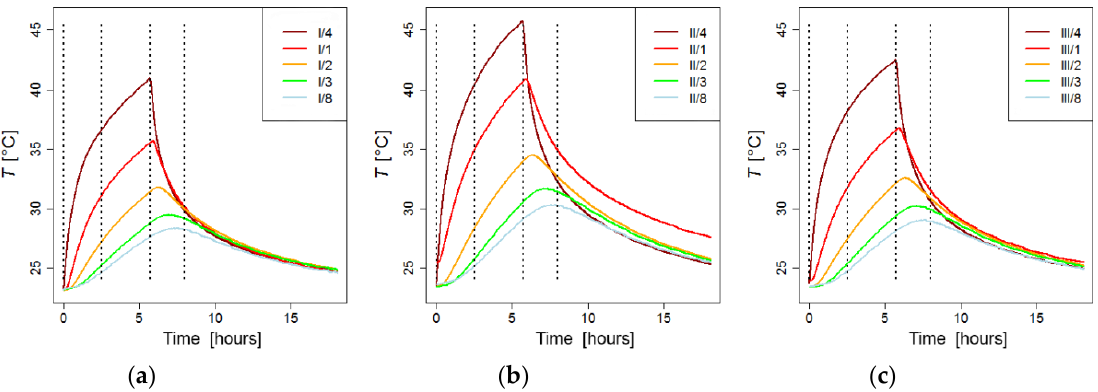
Figure 9. The temperature at discrete points of the concrete pillar as a function of time; the dashed lines denote the discrete times where the temperature distribution is presented over the cross-section: ( a ) Cross-section I; ( b ) Cross-section II; ( c ) Cross-section III.